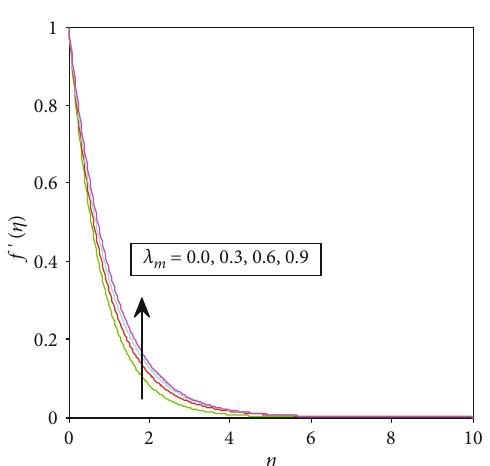
Figure 3: Velocity distribution for di ff erent values of the mixed convection parameter.